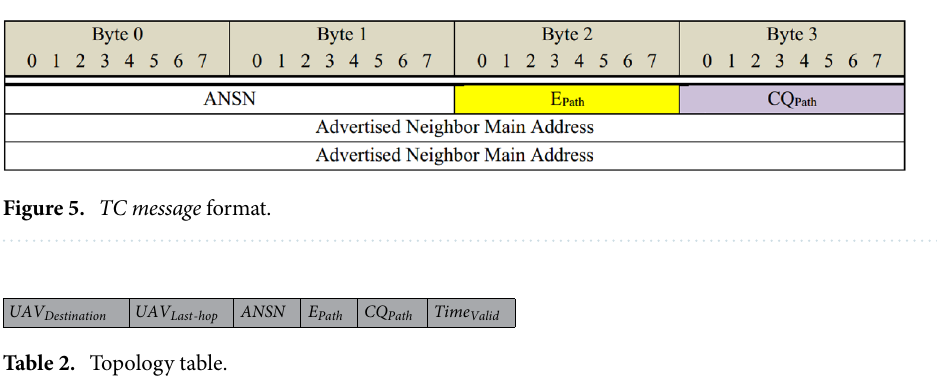
Table 2. Topology